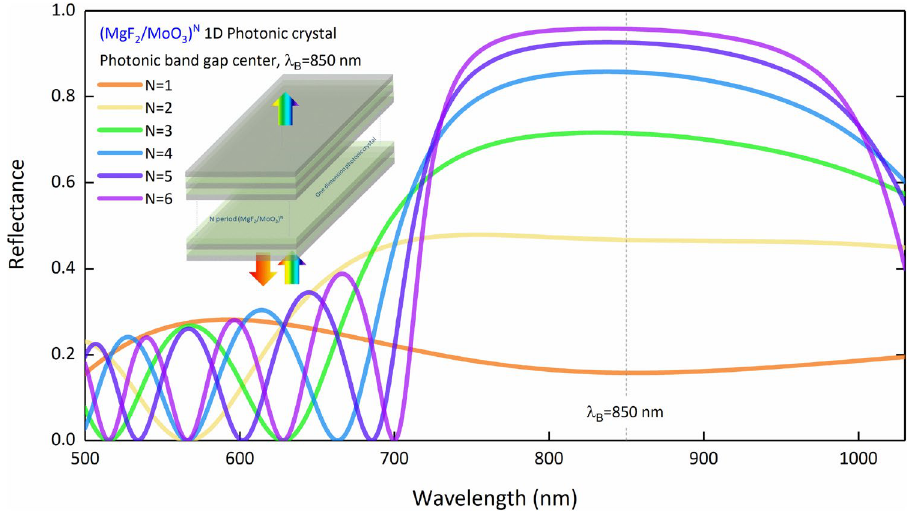
Figure 3. Reflection spectra of (MgF 2 /MoO 3 ) N 1D-PC system at different periods for (cid:31) B =850 nm. 1D-PC system is given as